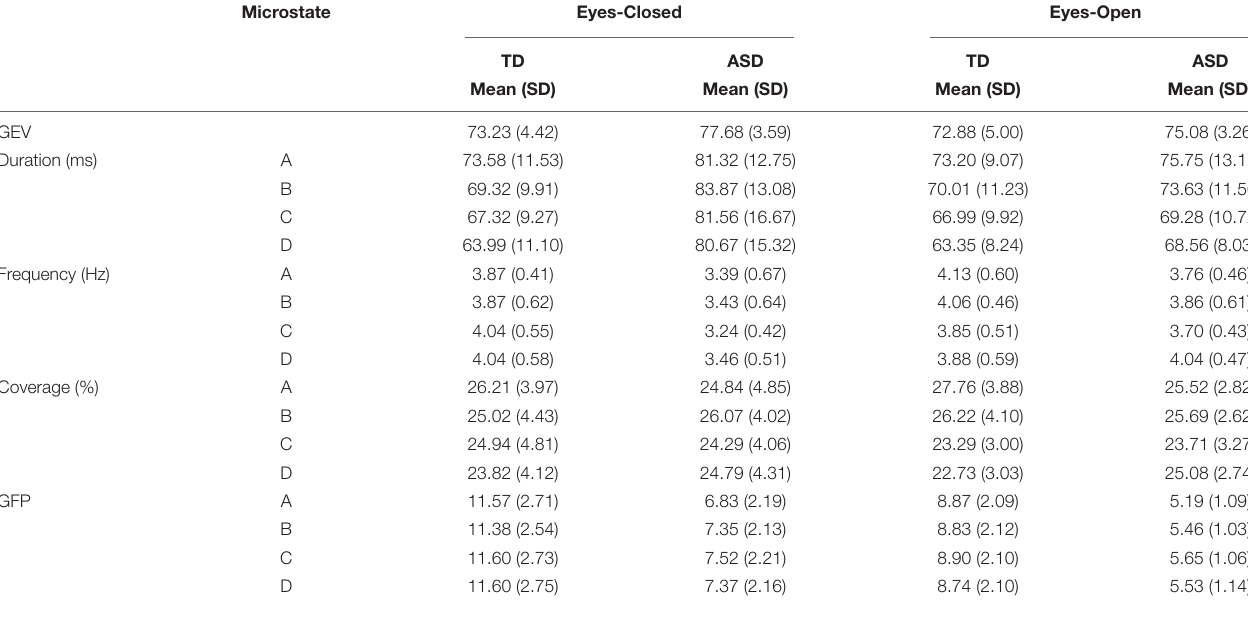
TABLE 2 | Descriptive statistics of microstate parameters from EC and EO